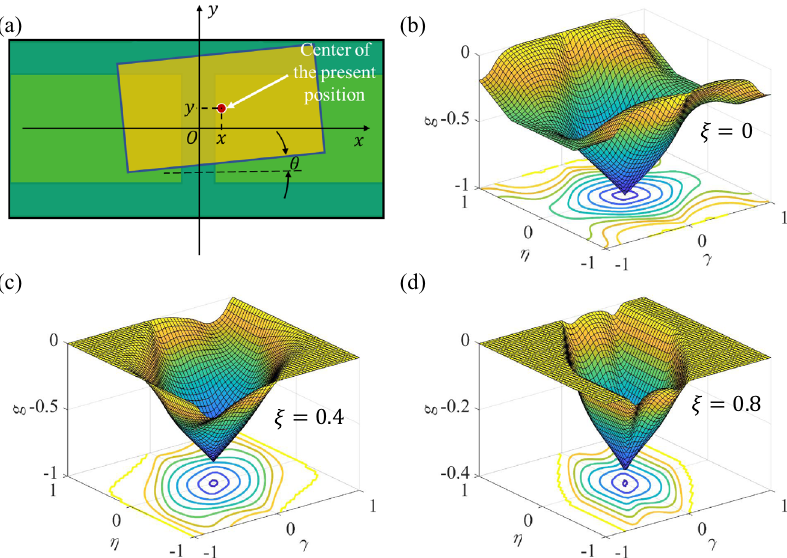
Fig. 3 Stability analysis of the ESL-resonator. a Illustration of the top view of the ESL-resonator. b – d Normalised energy surfaces in the f η ; γ g region for ξ ¼ 0 : 0 ; 0 : 4and0 : 8 in b , c , and d , respectively. For better visualisation of the results, we have plotted the contour lines of the surfaces in b – d . Two typical size ratios of W = L ¼ 0 : 5and s = L ¼ 0 : 2 are